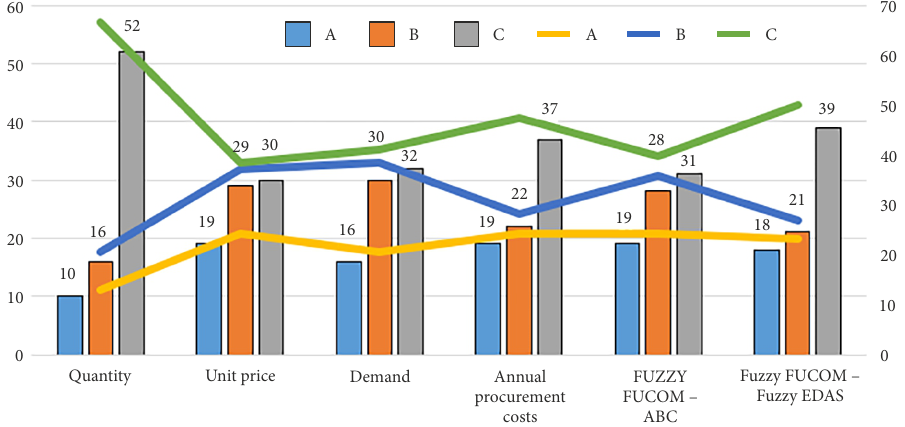
Figure 2. Comparison analysis in terms of inventory presence in groups A, B and C